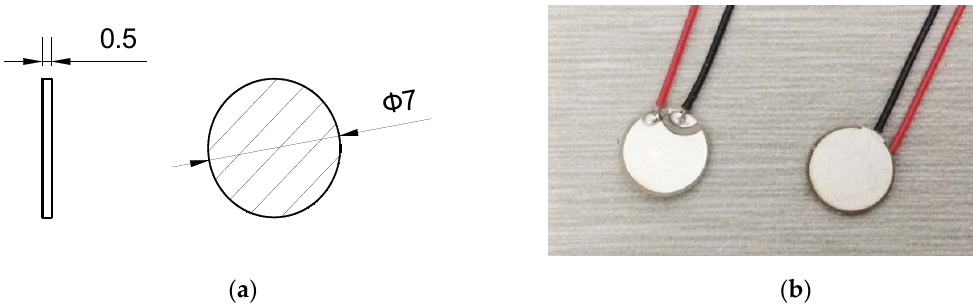
Figure 6. ( a ) Geometrical dimensions (mm) and ( b ) appearance of piezoelectric sensors. Table 2. Performance of piezoelectric sensor.